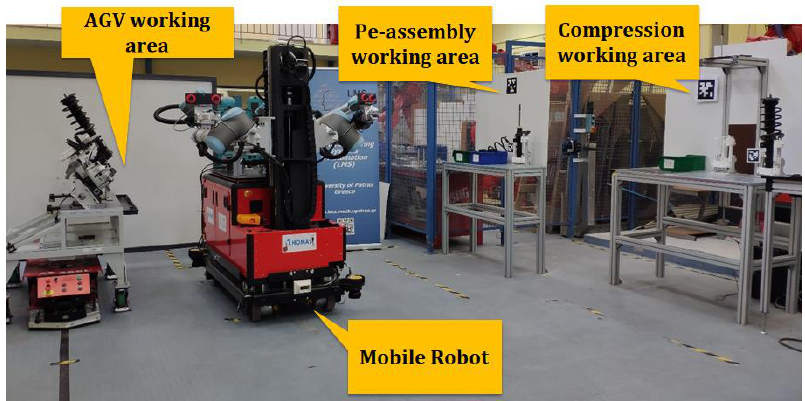
Figure 11. The selected configuration physically deployed.